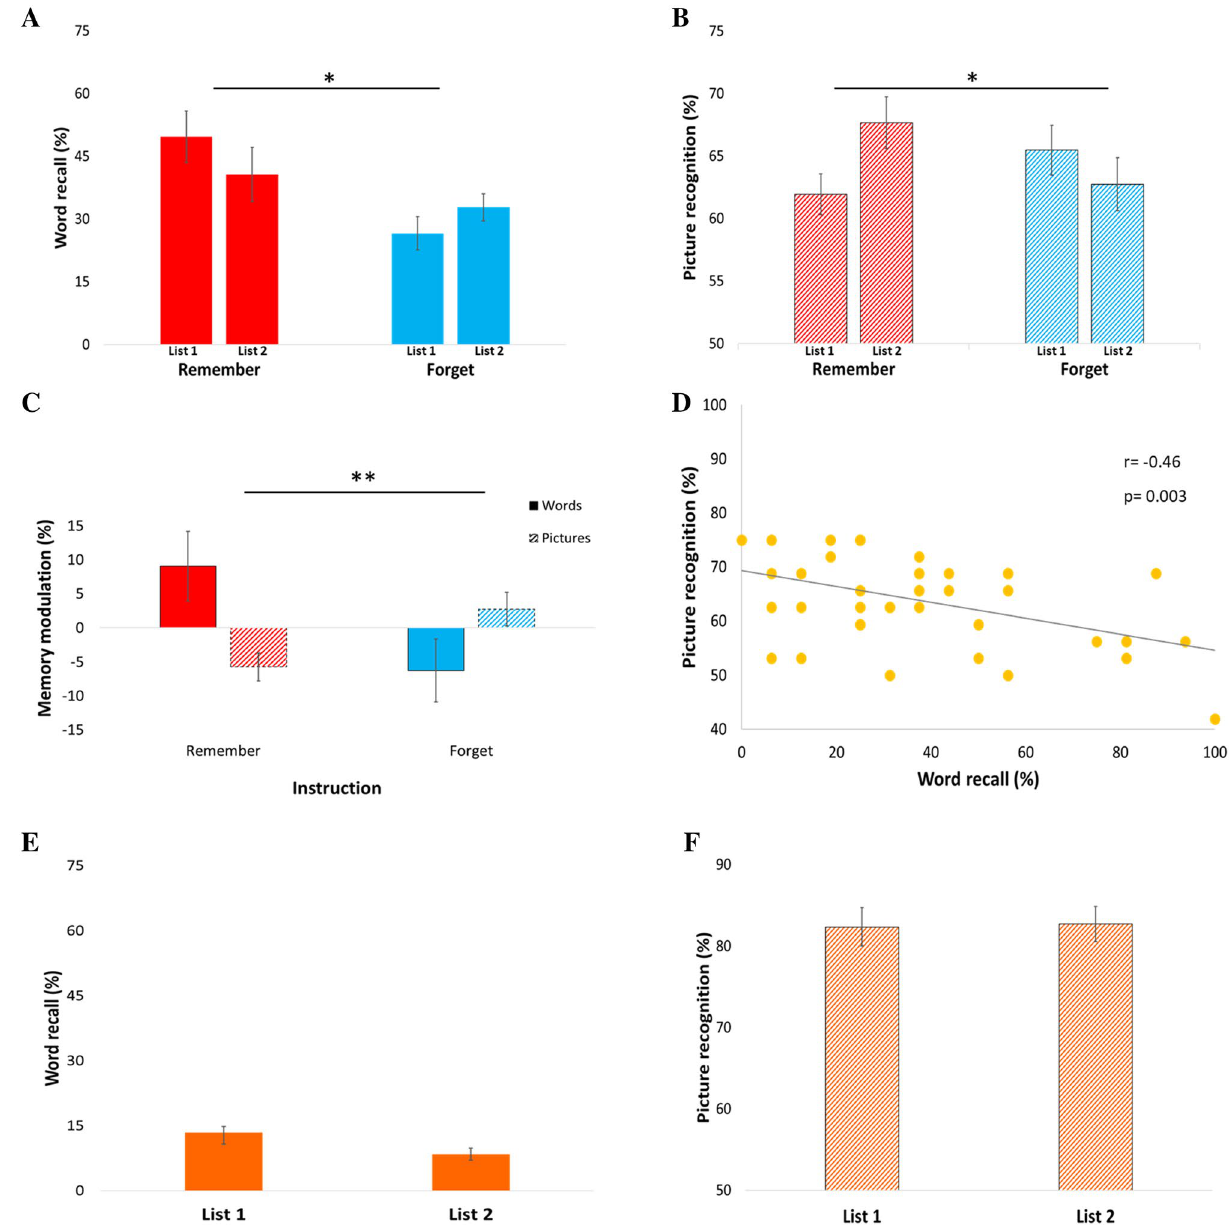
Figure 2. Memory modulation results ( A ) Direct memory modulation. Instructions to either remember (red) or forget (blue) the words differentially influenced word recall, with memory strength greater in the remember than in the forget condition (instructed list 1 relative to list 2). ( B ) Indirect memory modulation. Picture memory strength was lower when instructions were given to remember the words, compared to when instructions were given to forget the words (instructed list 1 relative to list 2). ( C ) Indirect modulation of memory for pictures was in the opposite direction to the memory for the words, with better memory for words